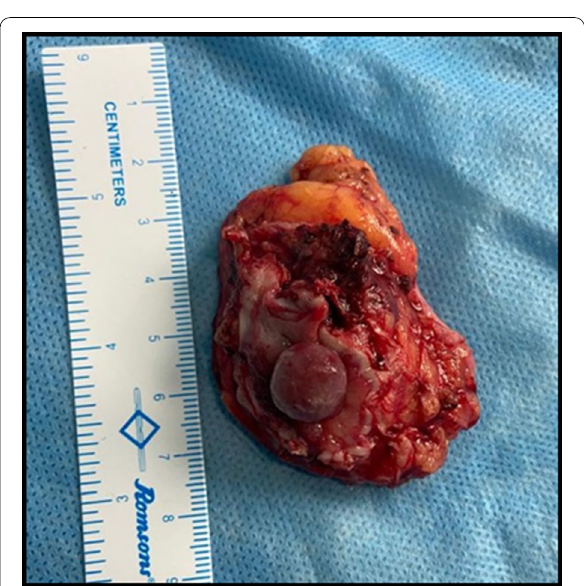
Fig. 5 Photograph of resected urinary bladder tumor shows a solid tan brown mass